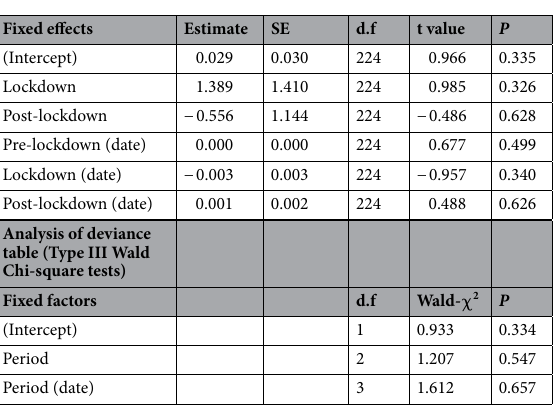
Table 3. Model summary, Analysis of Deviance (Wald Chi-squared tests) and Post-hoc Tukey adjusted pairwise comparisons for the model constructed to test number of rodent related residents’ complaints, received by the Council of the City of Sydney, according to date and COVID-19 restriction period. Model structure: Log (Complaints) ~ Period + Period (Date) + Random (Suburb); Family: Gaussian. Data comprised the number of rodent related residents’ complaints received by the Council from January 2019 to August